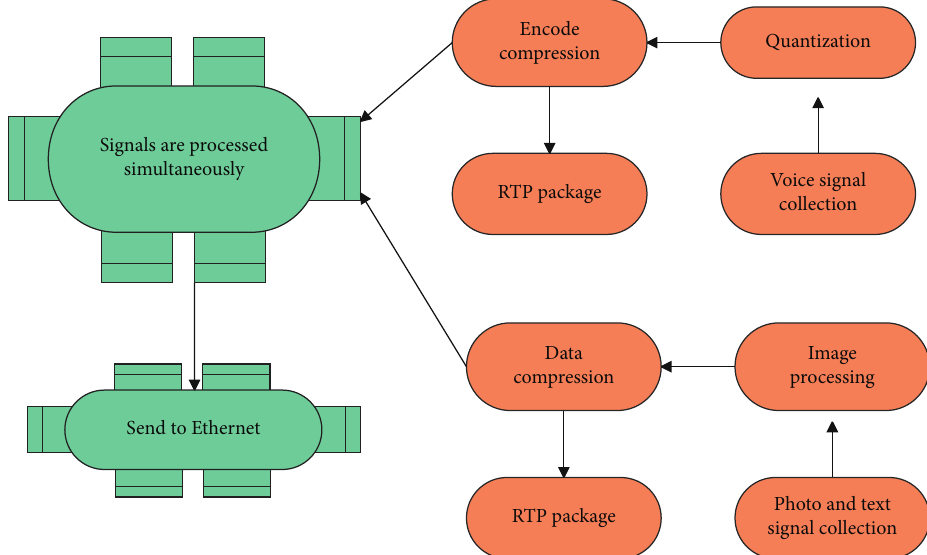
Figure 10: Block diagram of the system